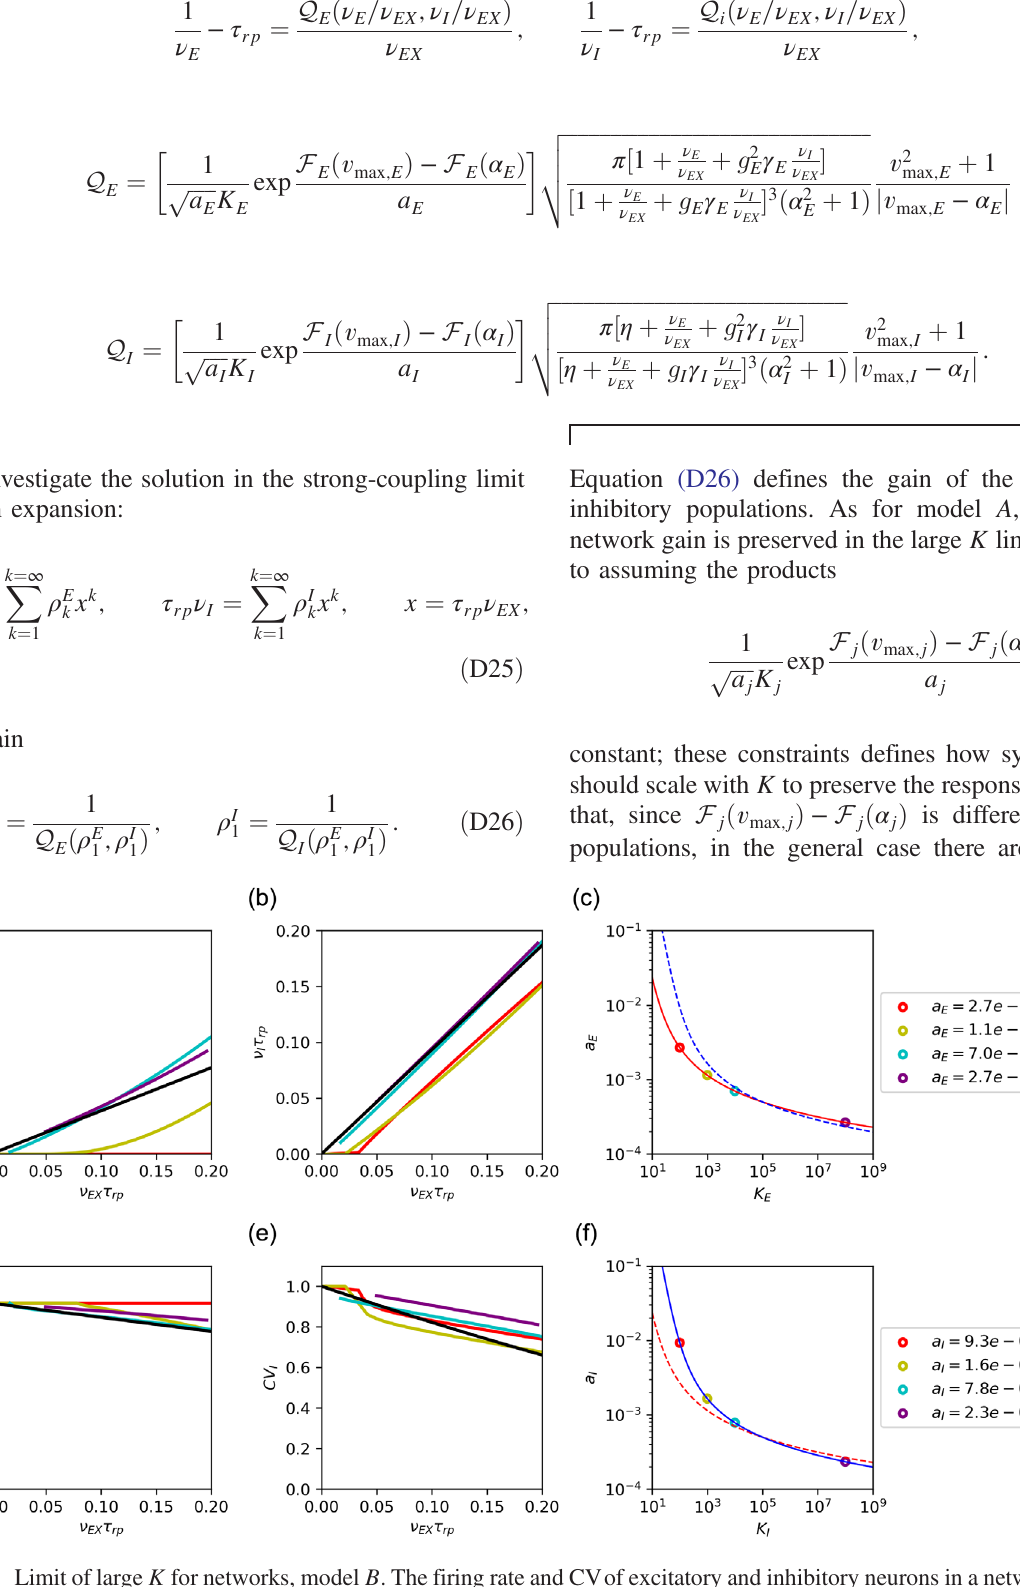
FIG. 13. Limit of large K for networks, model B . The firing rate and CVof excitatory and inhibitory neurons in a network predicted by the mean field model for different values of inputs and K ; the expected asymptotic behavior is shown in black. On the left [(c),(f)], we show the corresponding scaling relations with dots associated to the connectivity parameters. Simulations parameter: The two 20 . 0 and g 19 . 0 ; for both populations, a ¼ 0 . 0005 for K ¼ 10 5 ; other parameters are as in Fig. populations have g e ¼ i ¼